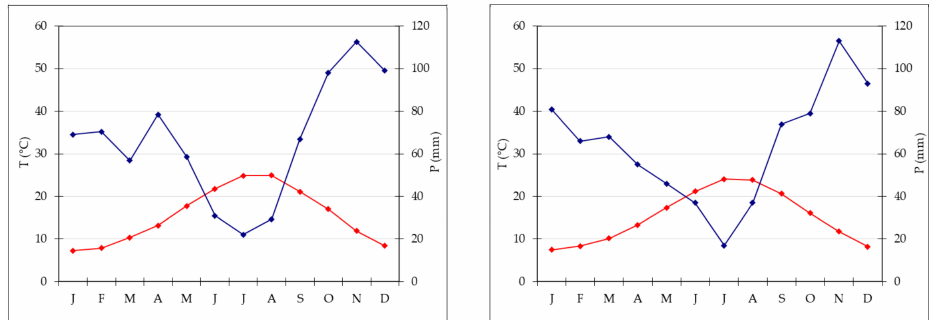
Figure 10. Thermo-Pluviometric Bagnolous-Gaussen diagrams of the stations Ciampino (left side diagram) and Monte Mario (right side diagram). Blue lines refer to rainfalls; red lines refer to temperatures. Axis x refers to months (e.g., “J” =